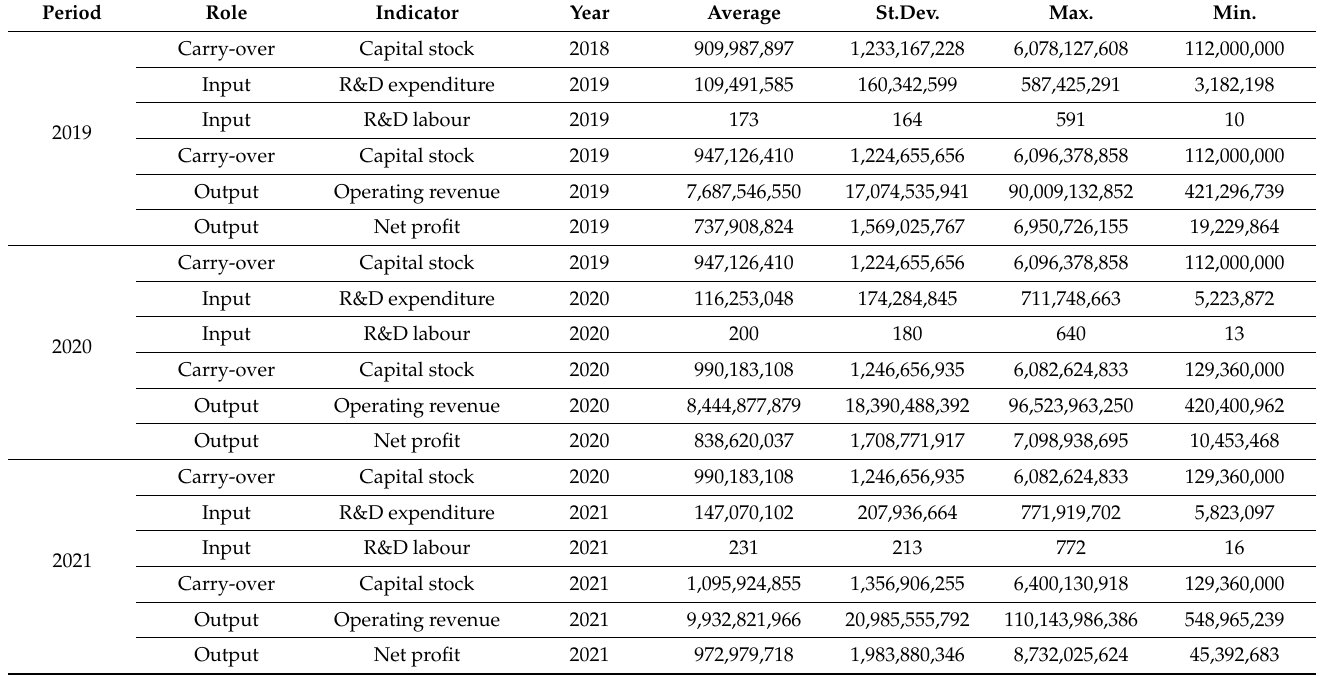
Table A2. Distribution characteristics of selected indicators per